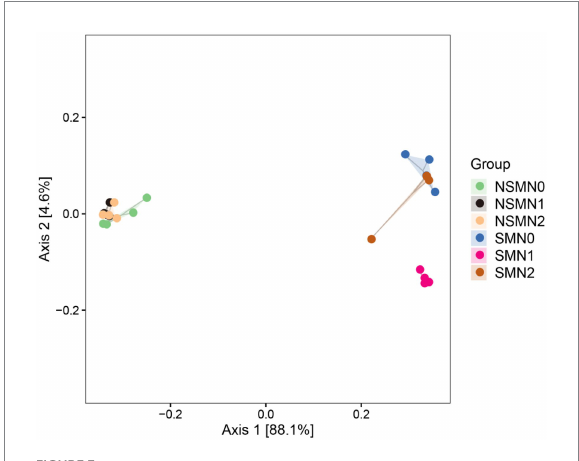
FIGURE 3 Principal coordinate analysis (PCoA) of microbial community composition in wheat rhizosphere soil under straw mulching and N fertilization treatments. NSM, no straw mulching; SM, straw mulching; N0, no N; N1, 120 kg N ha − 1 ; N2, 180 kg N ha − 1